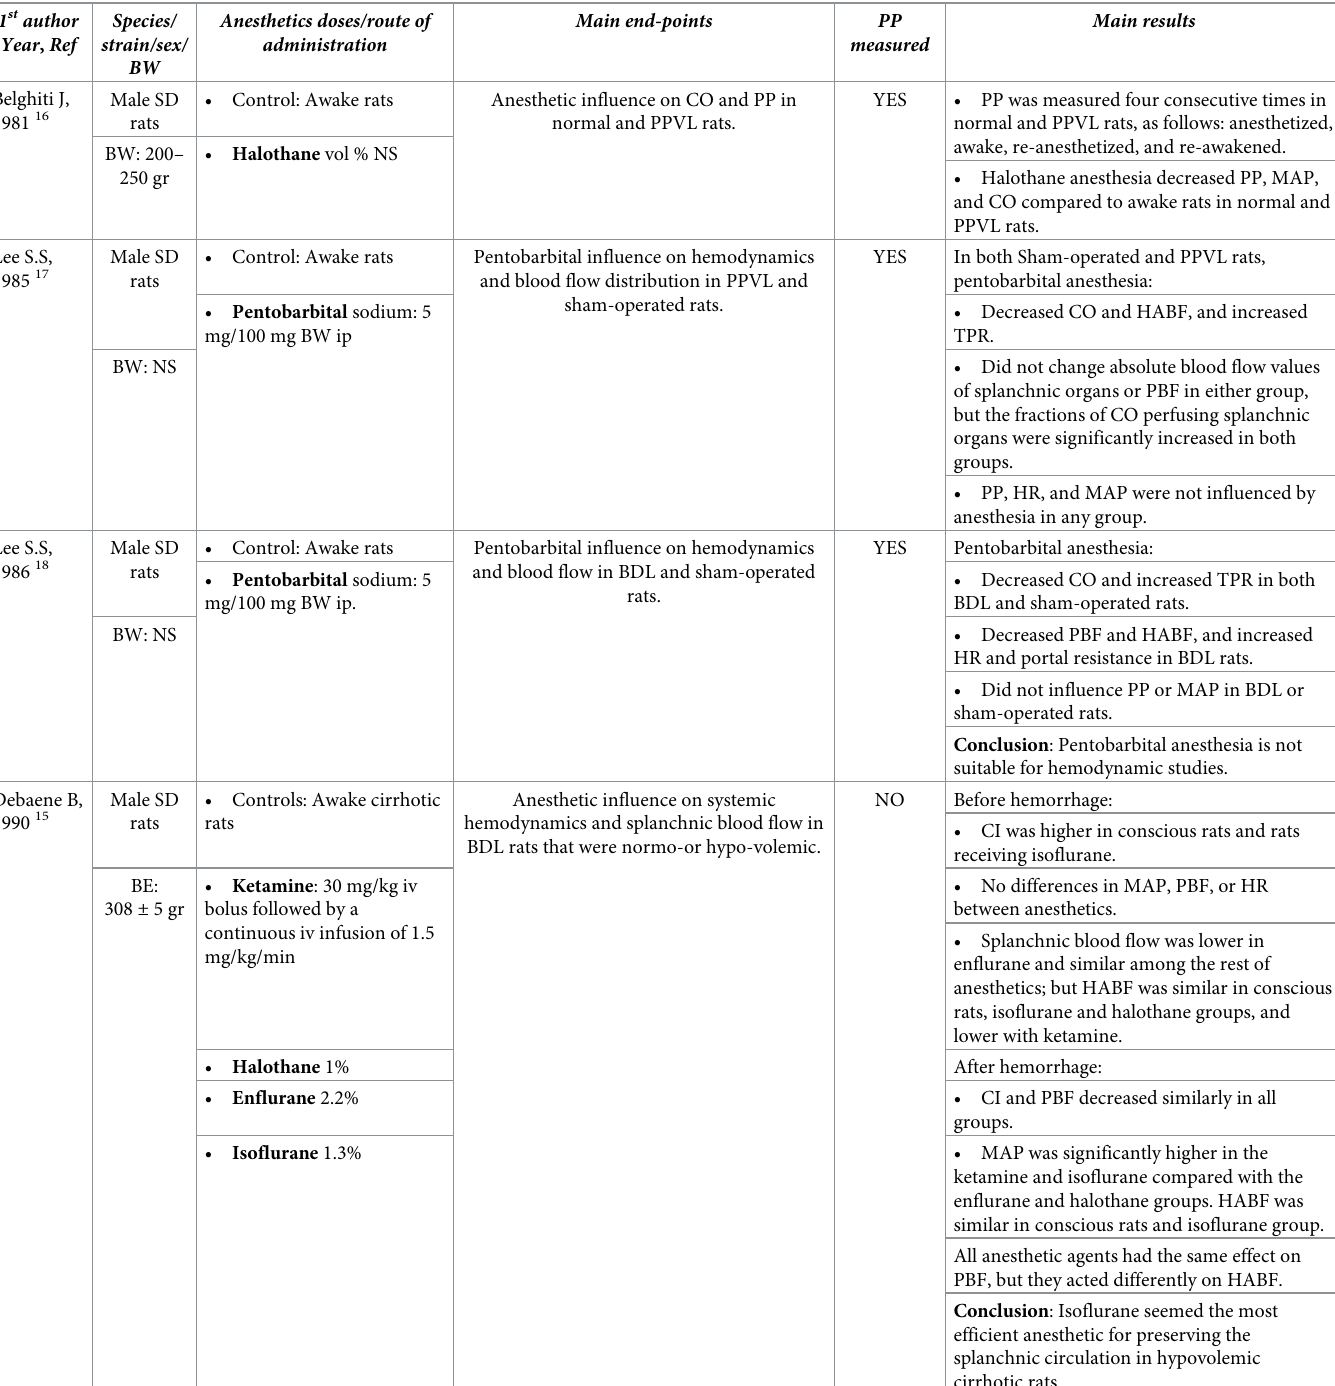
Table 1. Summary of studies evaluating the effects of anesthesia on hemodynamics in rats with experimental cirrhosis and/or portal